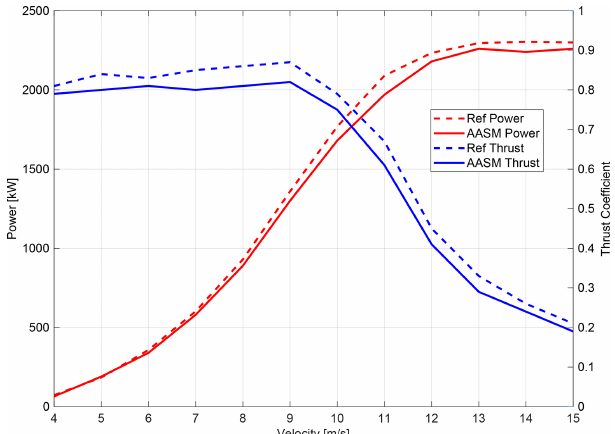
Figure 5. Comparison of simulated power and thrust coefficient in SP-Wind using the AASM against reference data (Göçmen and Giebel, 2016).